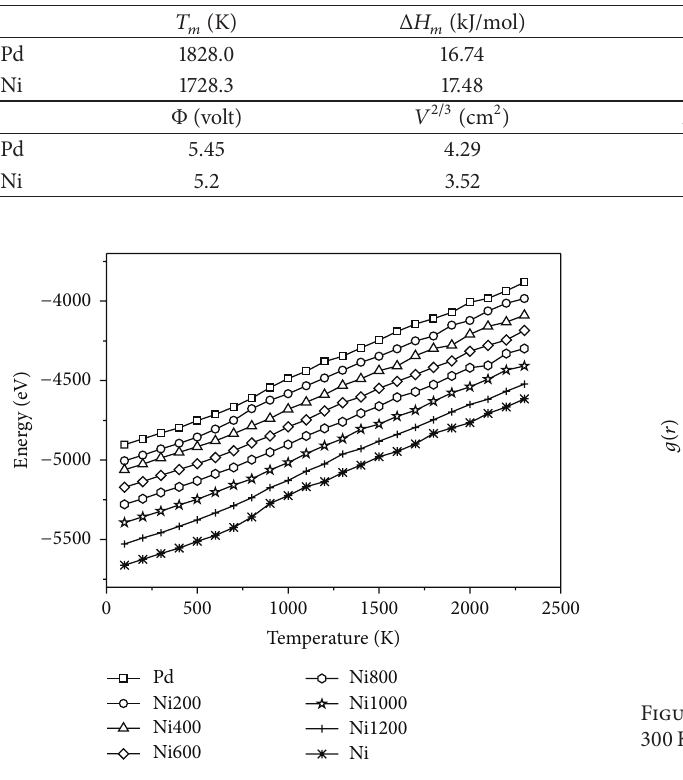
Figure 1: Total energy versus temperature curve for Pd-Ni clusters during cooling process.